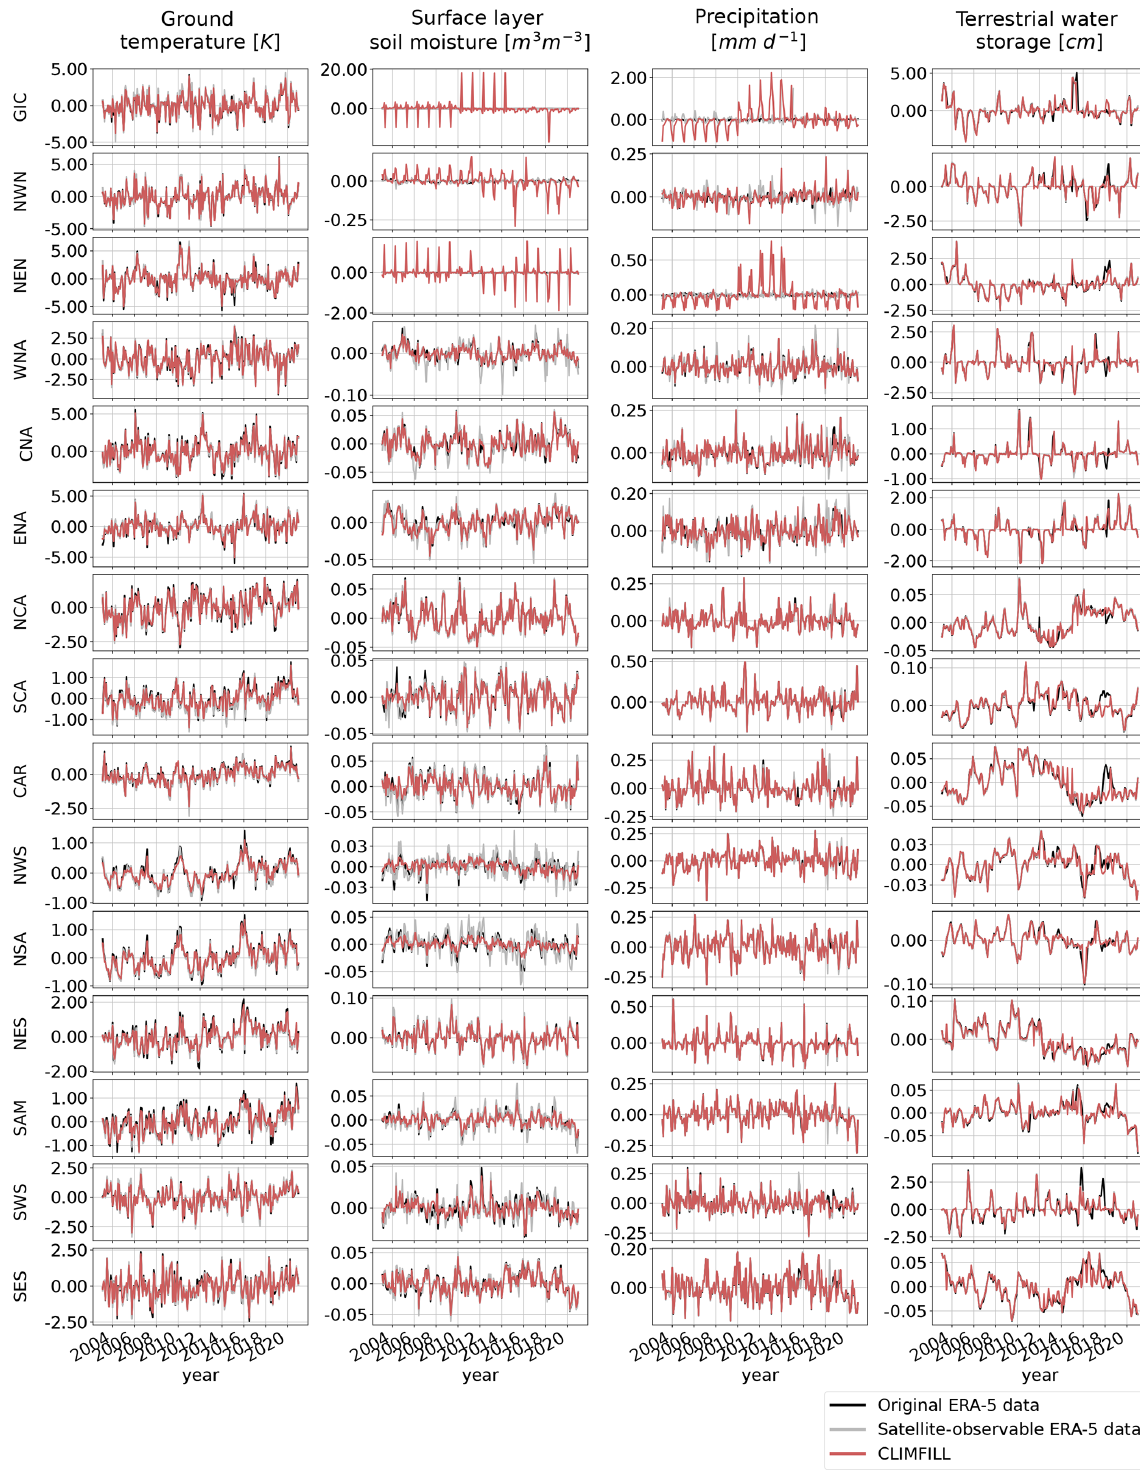
Figure A5. Interannual variability over all IPCC reference regions on land except Antarctica (AR6 regions, as described in Iturbide et al., 2020) for the original ERA-5 data, satellite-observed ERA-5 data, and data gap filled with CLIMFILL.